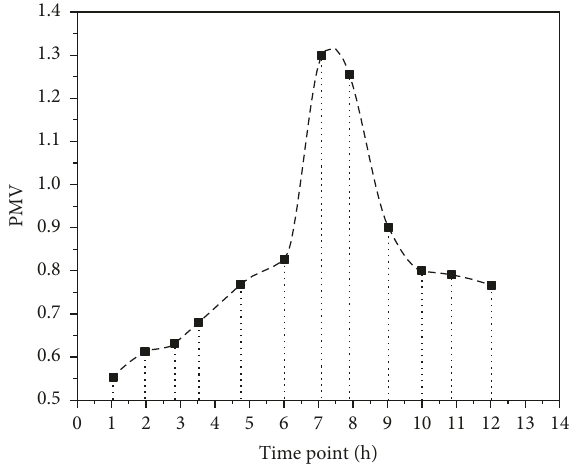
Figure 4: Variation of PMV with time at 27 °